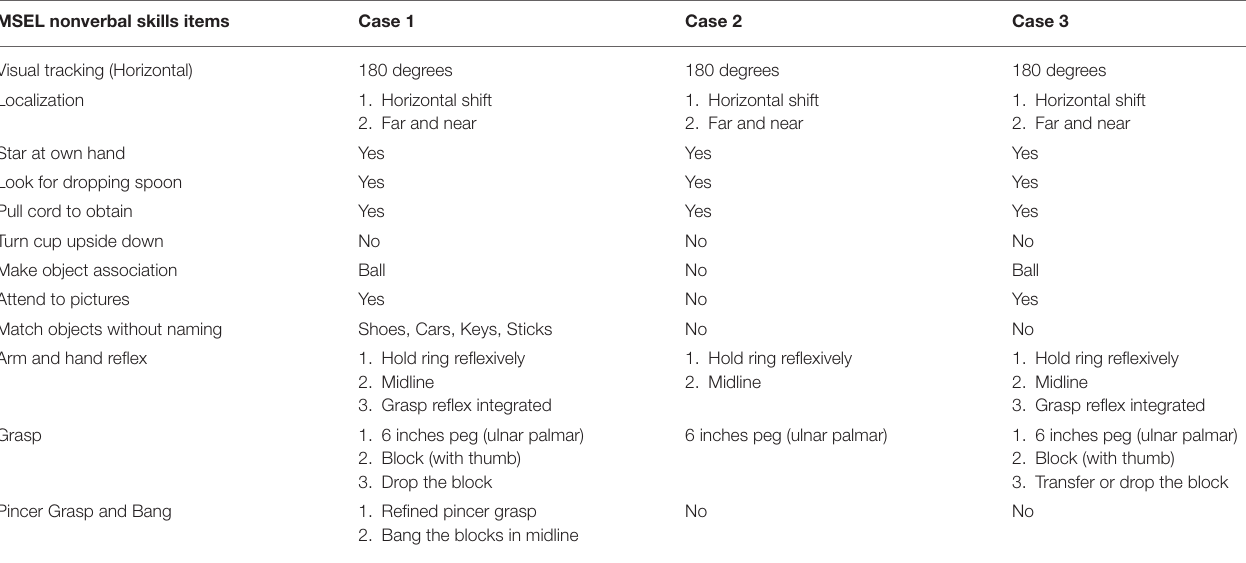
TABLE 3 | Developmental performance of MSEL nonverbal skills in the subjects with FOXG1-related syndrome. MSEL nonverbal skills